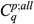
Ranking of the global cross-clustering coefficient.
Cqp;all for pairs of countries (A) and sectors (B). (C) As an example, the global cross-clustering coefficients between Germany and the world’s largest economies are shown.